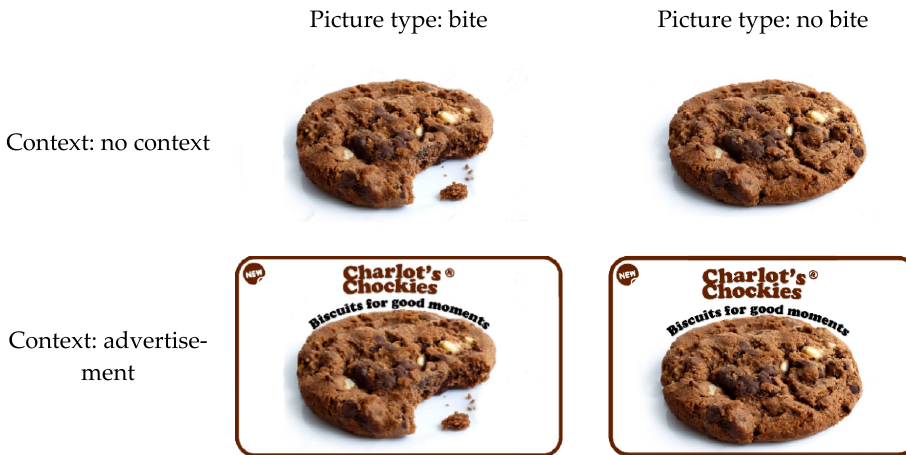
Figure 3. The used stimuli for Study 2.